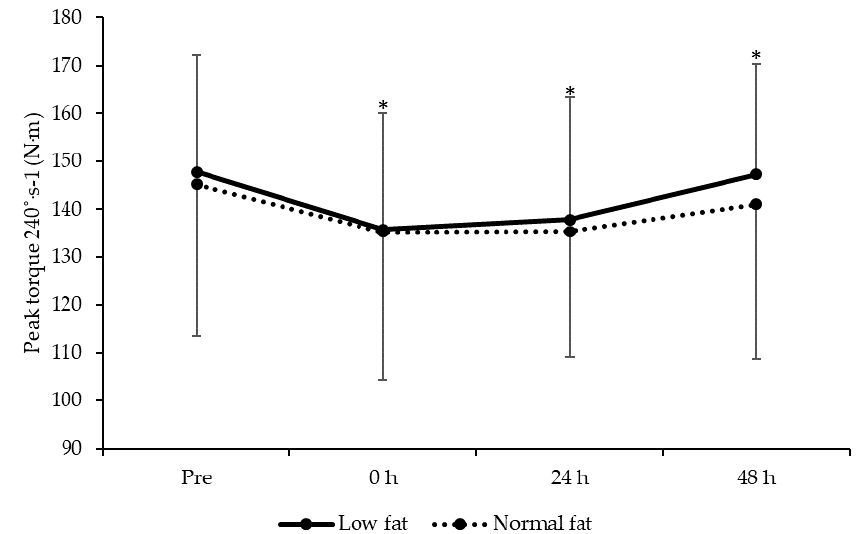
Figure 5. Changes in knee extensor peak torque at 240° ∙ s − 1 (mean ± standard deviation) between low- and normal-fat groups at pre, 0, 24 and 48 h after resistance exercise. * denotes significantly different from Pre for the whole sample ( P < 0.05).